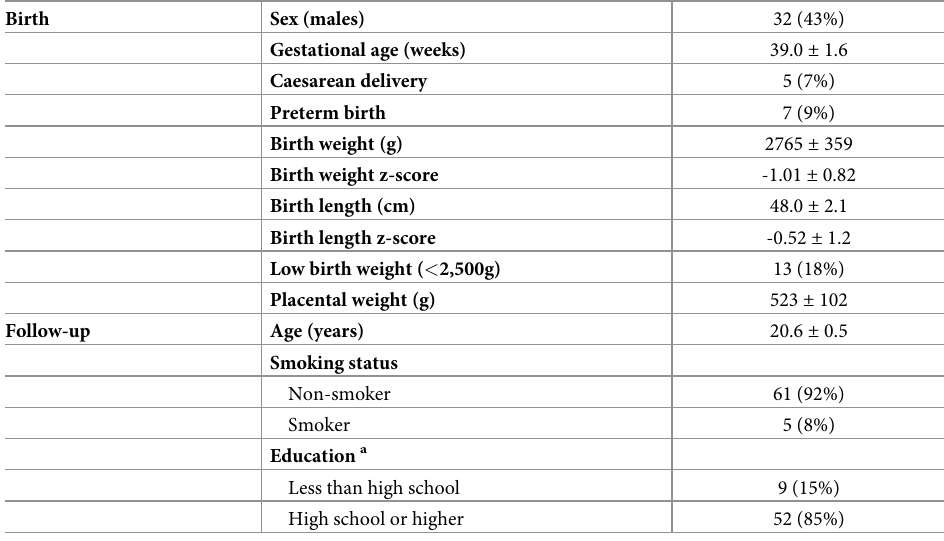
Data are means ± standard deviation (SD) or n (%), as appropriate. None of their mothers reported using tobacco or illicit drugs during pregnancy. a Smoking and education data were missing for 8 (11%) and 13 (18%) participants,